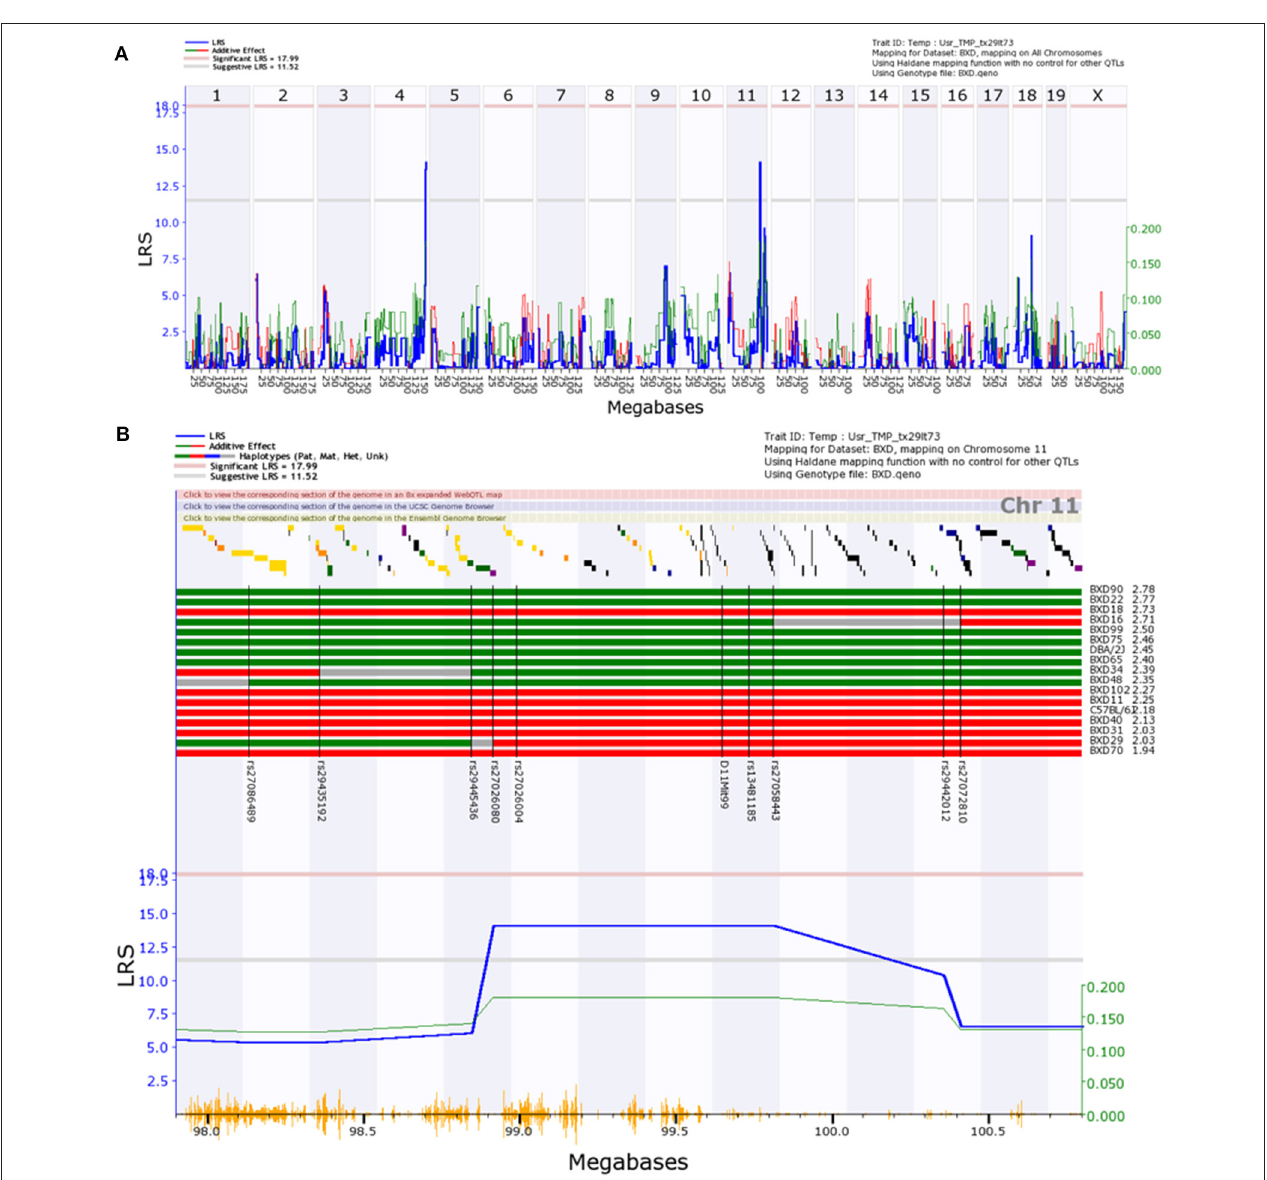
FIGURE 2 | Interval map of normalized ocular compliance ( φ norm ) across the mouse genome, as determined with the Volume Filling data analysis method. The blue line in each panel represents the likelihood ratio statistic (LRS), a measure of the linkage between differences in the measured trait ( φ norm ) and genotype markers. Thresholds for significant ( p < 0.05) and “suggestive” ( p < 0.63) peaks are indicated with horizontal pink and gray lines (Abiola et al., 2003). Red and green peaks indicate the contributions of the B6 and D2 alleles, respectively. In (A) , a suggestive peak is observed on Chr11. In (B) , a magnified view of the region of interest is shown, accompanied by a haplotype map. B6 and D2 alleles are denoted by red and green bars, respectively, and are ordered from high to low φ norm values. Unmapped regions are shown in gray. Genomic markers used for interval mapping are labeled on the haplotype map and indicated with black vertical lines. Yellow vertical lines along the bottom of subplot (B) mark SNP